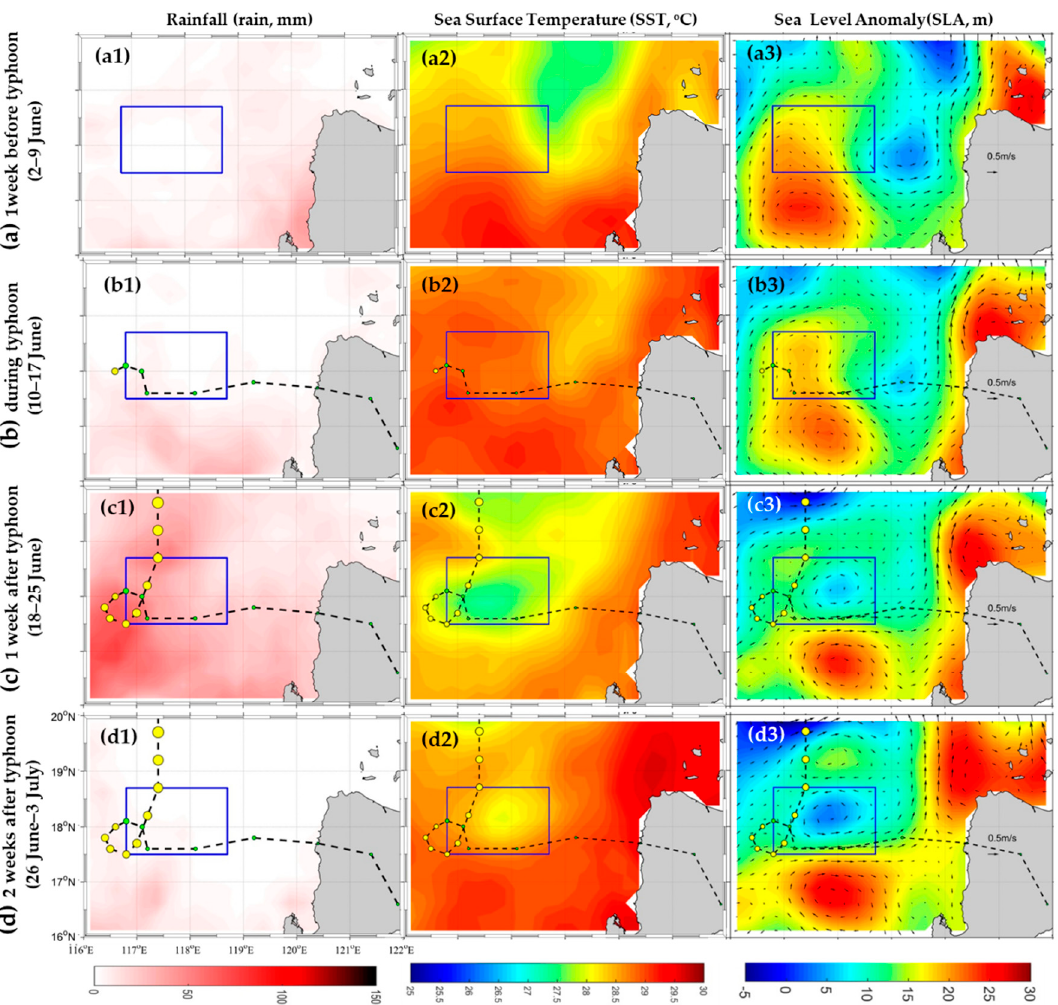
Figure 3. Spatial distribution map of rainfall, sea surface temperature (SST), and sea level height anomaly (SLA) with sea surface geostrophic currents (geo-SSCs) before and after the typhoon (first column: Rainfall (mm); second column: Sea surface temperature (SST, ◦ C); third column: SLA (cm) with geo-SSCs (m / s); ( a – d ) represent 1 week before, during, 1 week after, and 2 weeks after the typhoon Linfa; the blue box indicates the study area; the dotted line indicates the typhoon